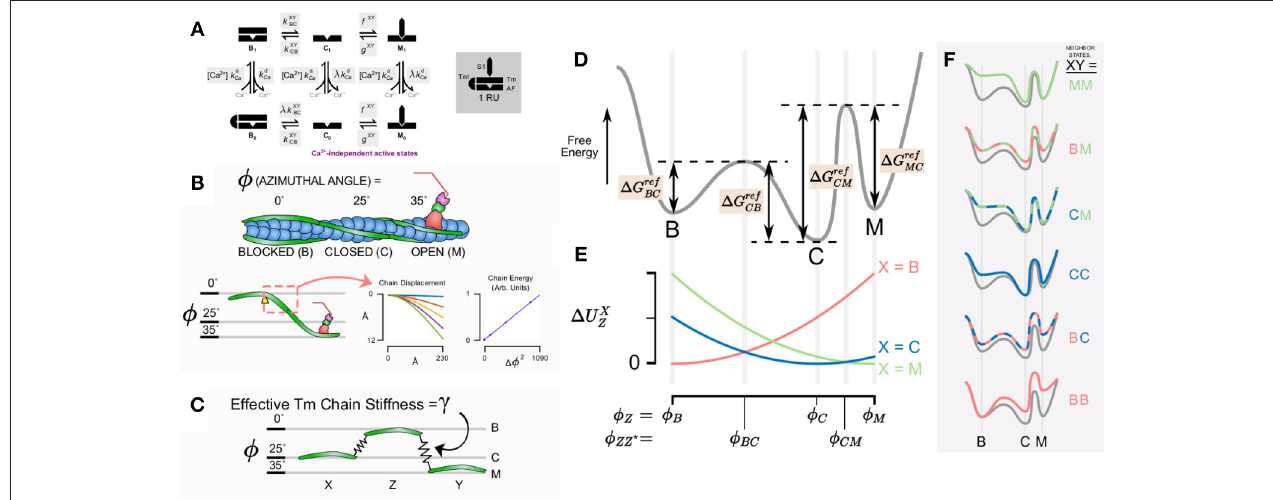
FIGURE 1 | Schematic diagram of model components, states, and conceptual underpinning of the cooperativity scheme. (A) State diagram for the assumed six states in the thin filament model with kinetic rates governing each state transition (shaded). (B) The model takes into account the azimuthal angle displacement required for the state transition from blocked to closed to open for a given regulatory unit. Quasi-explicit representation of Tm bending shows that stored energy in the molecule is proportional to the square of the azimuthal angle change. (C) This suggests that the system can be represented simply as a given regulatory unit Z connected to its neighbors X and Y by linear springs. (D) The conceptual reaction coordinate diagram for a given regulatory unit detached from its neighbors considers the free energy barrier from the blocked state to closed state to open state. (E) Magnitude of strain energy contribution for a given neighbor X depends on the intermediate angles between a transition for the state of a given regulatory unit and the state of the neighbor. (F) The overall energy barriers for the transitions of a given regulatory unit depends on the contribution of the strain energy with respect to the states of its neighbors X and